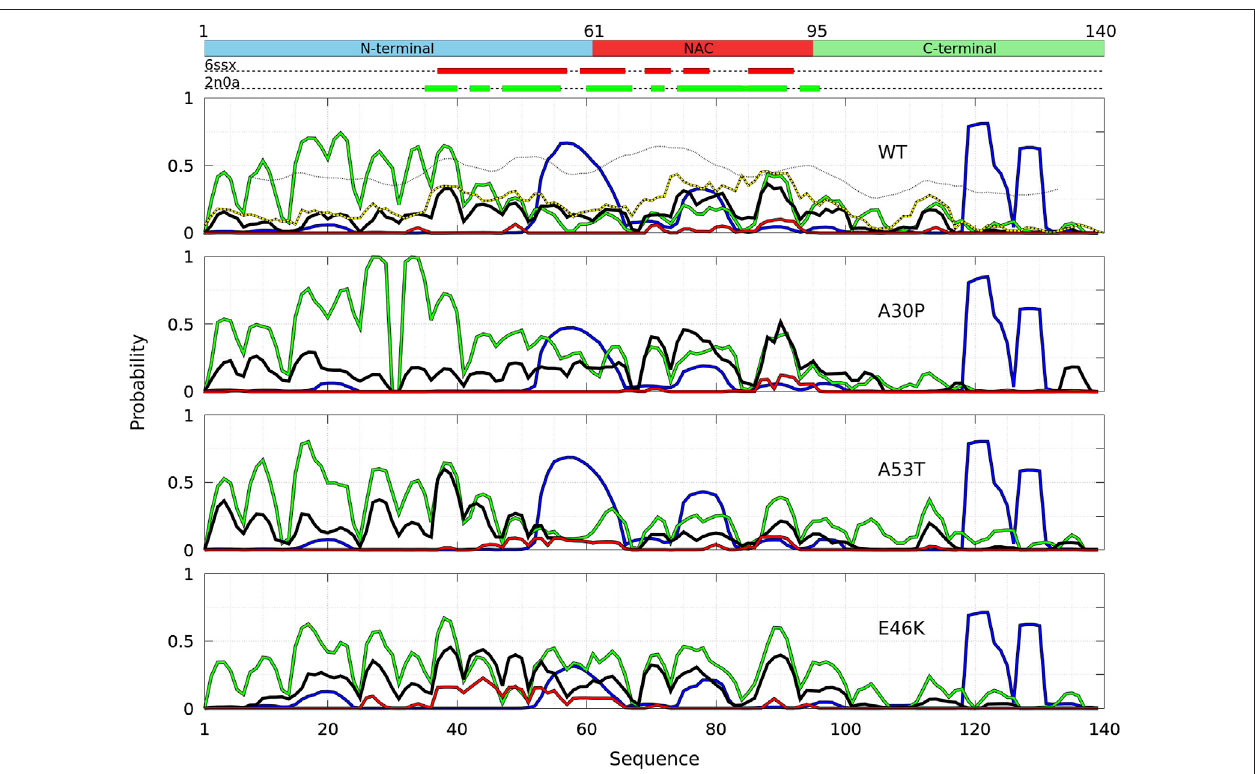
FIGURE 6 | Analysis of the secondary structures for the complete ensemble of α -syn dimers found in molecular dynamics simulations for the WT and the mutants using theCUTABIalgorithm(Guzzoetal.,2021).Probabilitiesforeachresidue topertain toan α -helix(blue),toanintra-molecular β -sheet (green),toanintermolecular β - sheet (black), and to a native intermolecular β -sheet fi bril type (red). The probability for each residue to form an intermolecular contact ( Figure 2 ) is shown for the WT (black/yellow broken line) for comparison. The propensity to form a β -sheet calculated from the empirical scale of Chou and Fasman with the Protscale online tool (https://web.expasy.org/protscale/) using a window of 15 residues and a linear interpolation with a weight of 0.10 for the window edges is also represented (dotted line) for the WT. The red and green rectangles on the upper dotted bars describe the locations of the intermolecular β -sheets identi fi ed by CUTABI in the experimental structures of α -syn fi brils with the PDB IDs 6ssx and 2n0a,